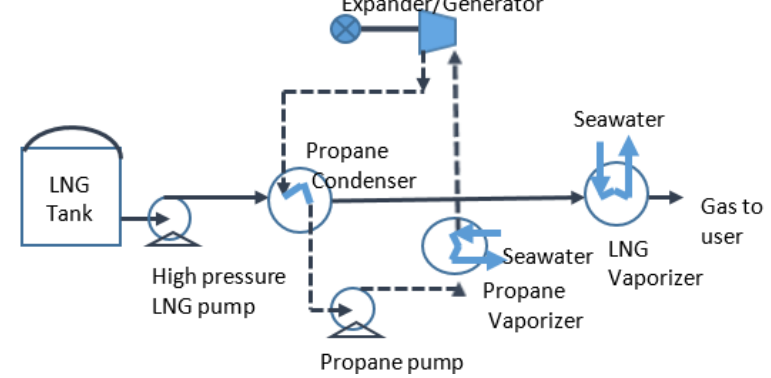
Figure 8. LNG cold power generation.